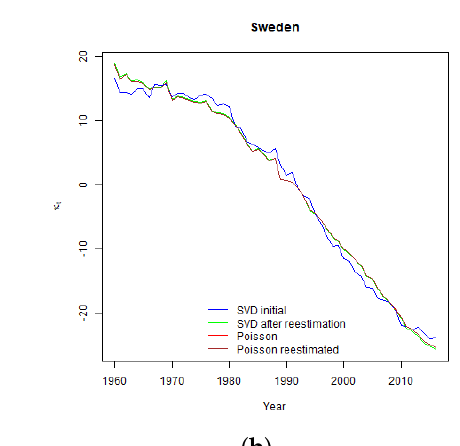
Figure A1. Lee-Carter model parameters β x estimated using SVD and Poisson (before and after smoothing) methods using data of Lithuania ( a ), Sweden ( b ), Poland ( c ) and the Netherlands ( d ).